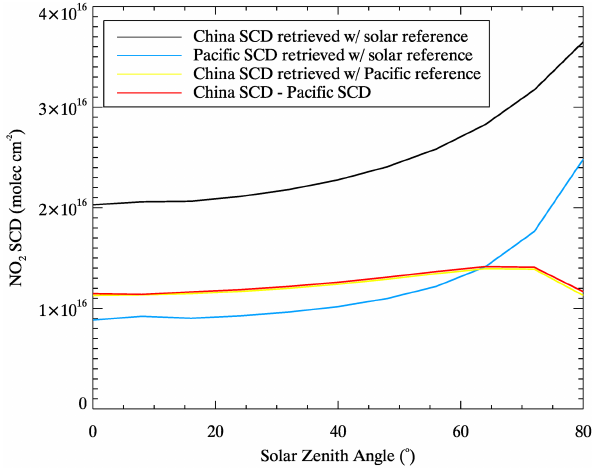
Figure 3. The retrieved NO 2 SCDs from DOAS fitting spectra modelled using SCIATRAN based on the Pacific and Chinese CAMELOT scenarios (Fig. 2) using a range of solar zenith angles (SZA). The red curve indicates the difference between the total SCD of the Pacific and Chinese scenarios directly modelled by SCIA- TRAN, while the other curves show the SCDs retrieved by using a solar or Earth radiance reference spectrum in the DOAS